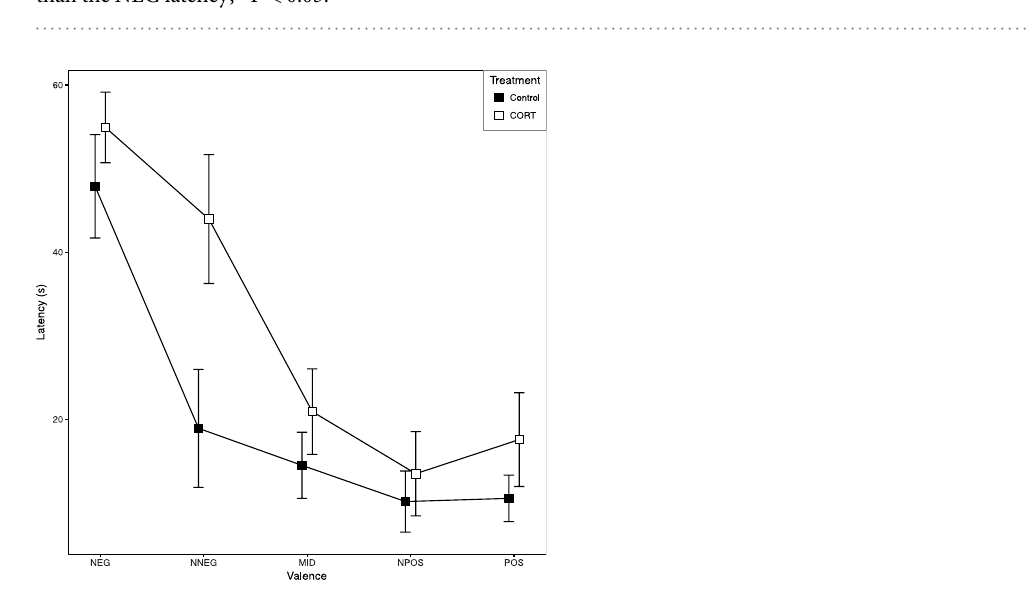
Table 1. Difference in latencies to approach POS and NEG during judgment bias testing. Notes: 1 For all birds N POS = N NEG = 9; 2 P-values are from a one-sided test of the alternative hypothesis that the POS latency is shorter than the NEG latency; * P < 0.05.